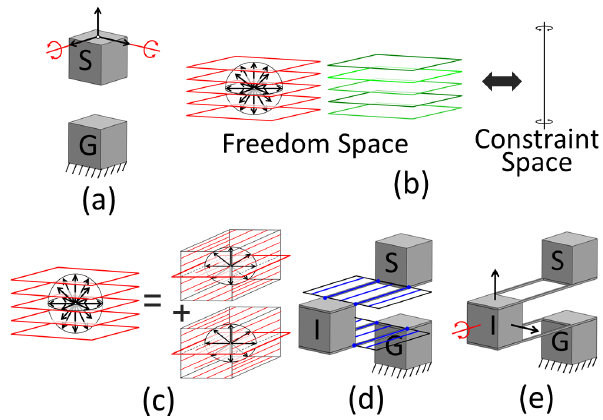
Figure 9. Desired DOFs (a), system’s freedom and constraint space (b), intermediate freedom spaces selected from the system’s freedom space (c), flexure elements selected from the intermediate constraint spaces (d), and the intermediate body’s under-constrained DOFs (e)